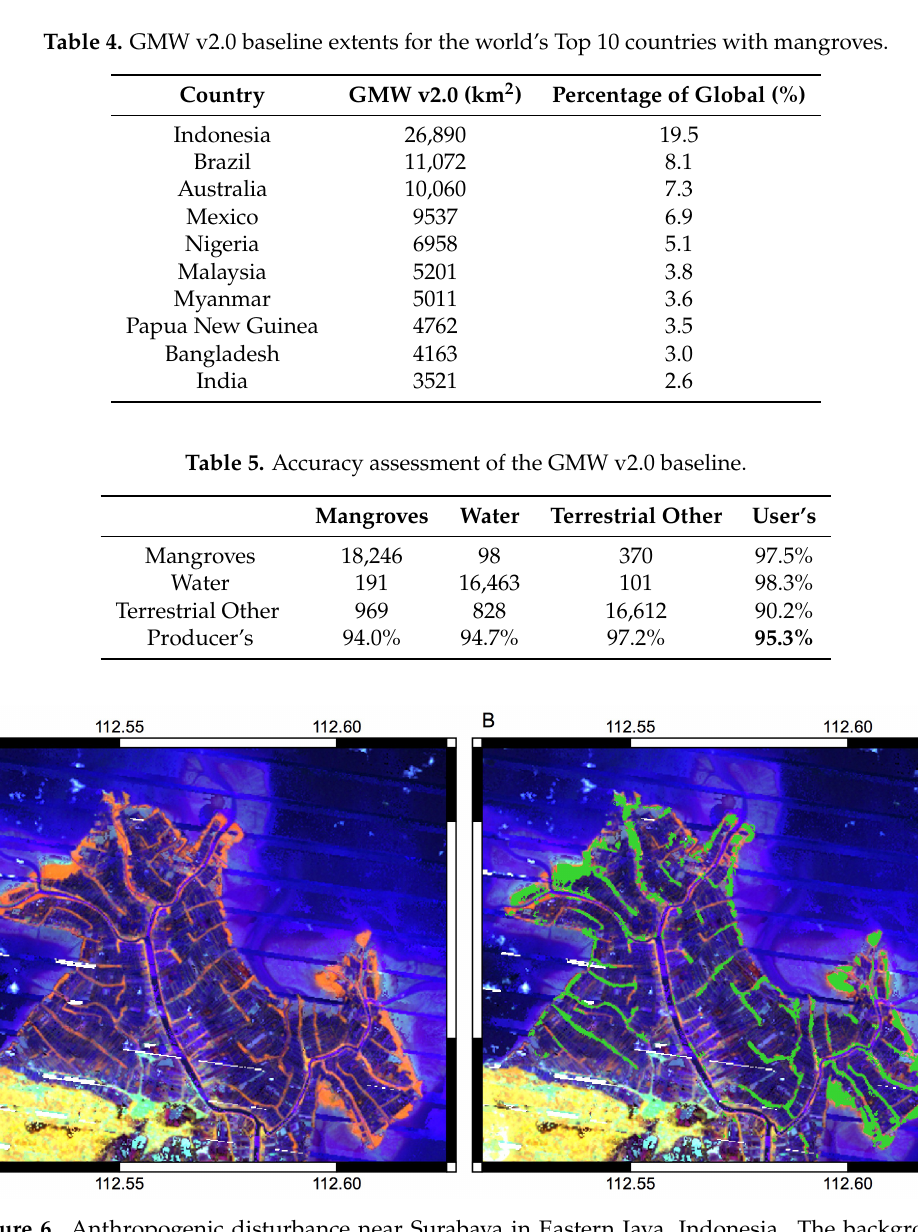
Figure 6. Anthropogenic disturbance near Surabaya in Eastern Java, Indonesia. The background imagery is the 2010 Landsat composite generated for this study, visualised using the NIR, SWIR and Red wavelength bands. ( A ) The Landsat composite, where the mangroves appear orange within the band combination: and ( B ) the Landsat composite with the GMW v2.0 baseline displayed over the top, in